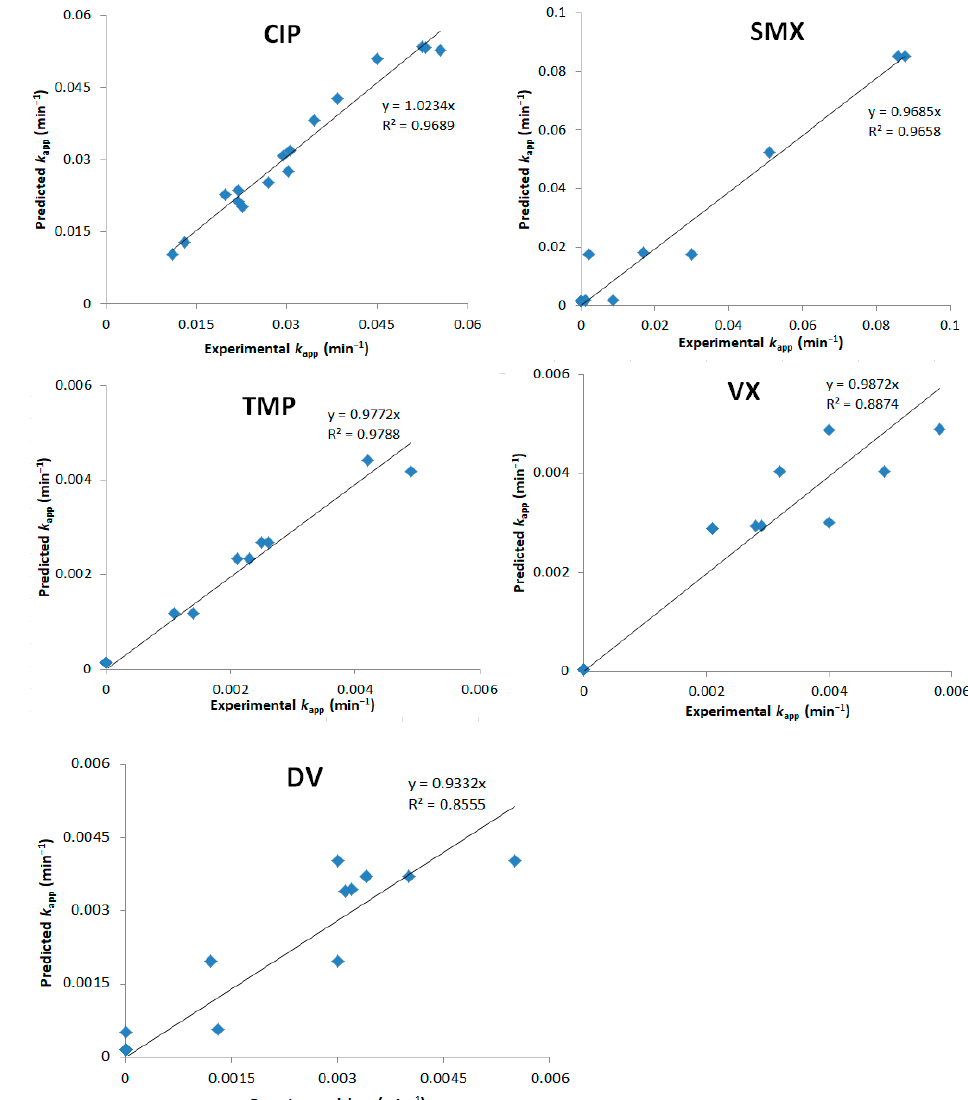
Figure 3. Model predictions vs. experimental k app values for the categorical DoE.